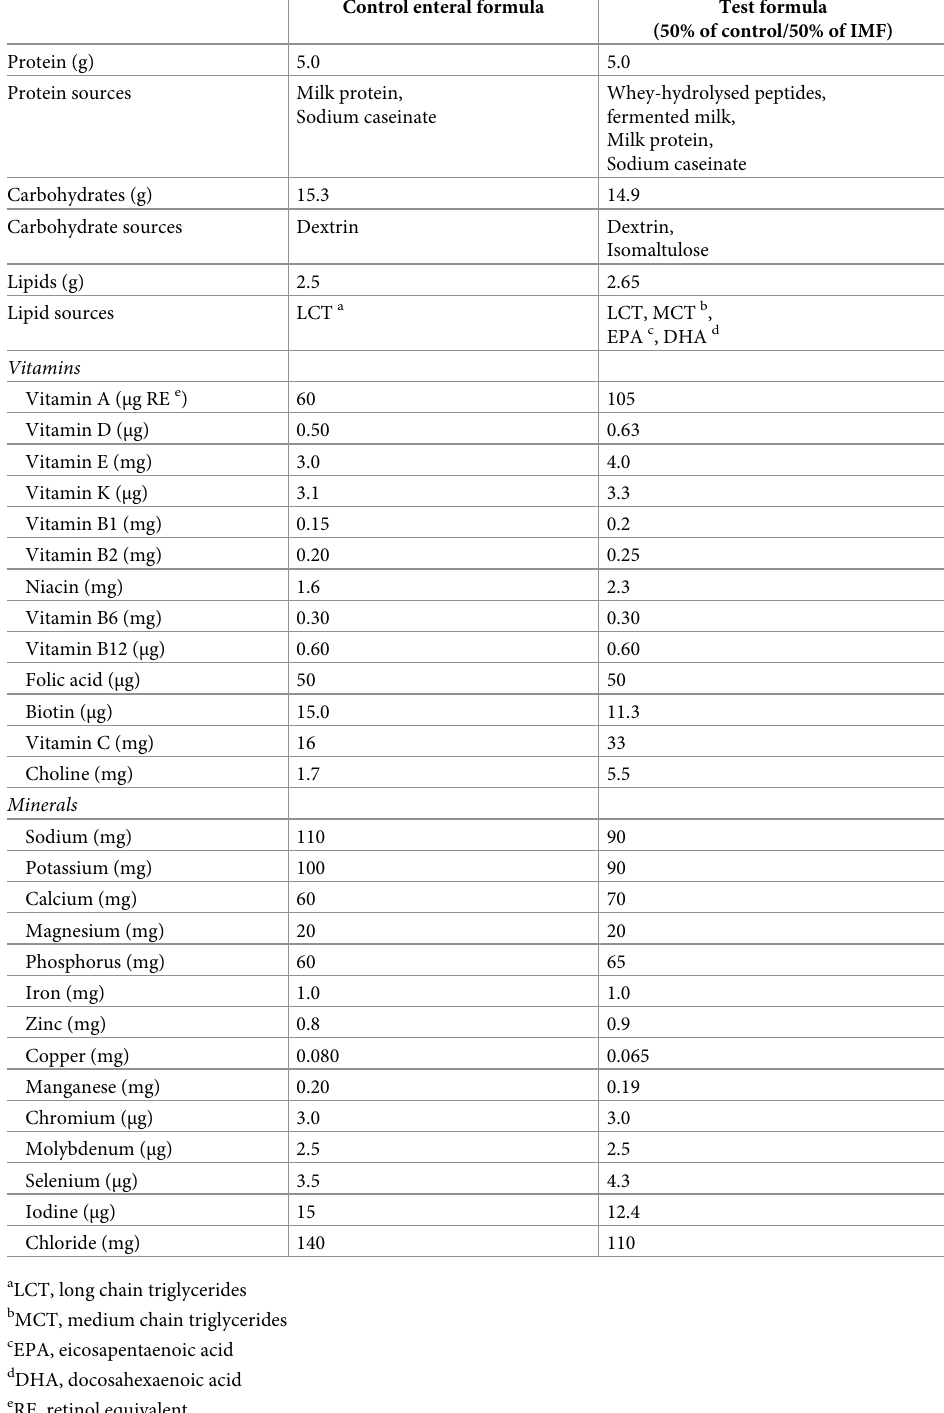
Table 1. Nutritional contents of the test formulas (per 100